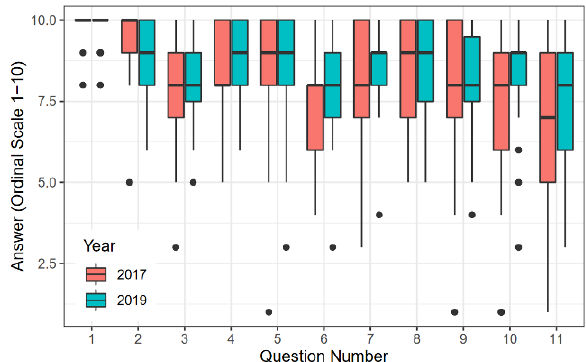
Figure 12. Results from past and recent edition of answers to questions with ordinal-scale answers (10 - high/good and 1 - low/bad) – question number is related to enumeration in Table 4. Line represents median and box the interquartile range - 25th and 75th